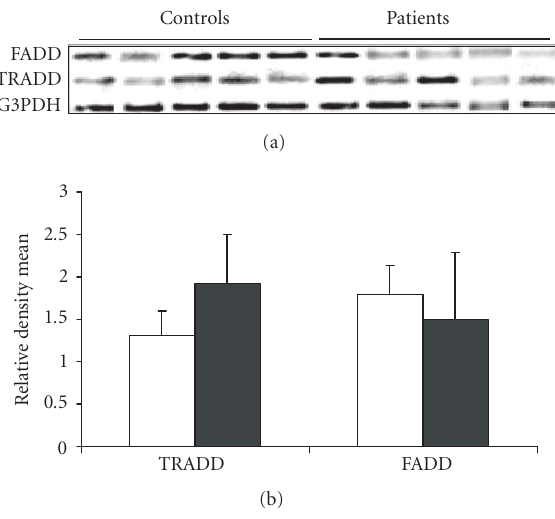
Figure 3: (a) Gene expression profile of TRADD and FADD from PBMCs of representative healthy controls and RA patients. (b) Relative density mean (density of gene specific product/density of housekeeping gene G3PDH) of 30 healthy controls and 27 RA pa- tients for the expression of TRADD and FADD genes.